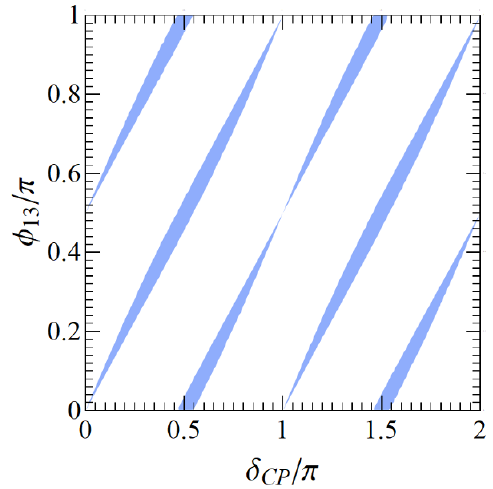
Figure 6 . Predicted correlation between the Dirac CP phase (cid:14) CP as a function of the solar mixing angle (cid:18) 12 in the case of generalized (cid:22) (cid:0) (cid:28) re(cid:13)ection, when (cid:18) 13 and (cid:18) 23 are required to lie in their 3 (cid:27) ranges. The vertical orange and yellow bands are the currently allowed 1 (cid:27) and 3 (cid:27) (NO case) respectively and the star denotes the best (cid:12)t point [3]. The green and light blue hatched regions correspond to (cid:2) = (cid:25)= 9 and (cid:2) = (cid:25)= 6 respectively.